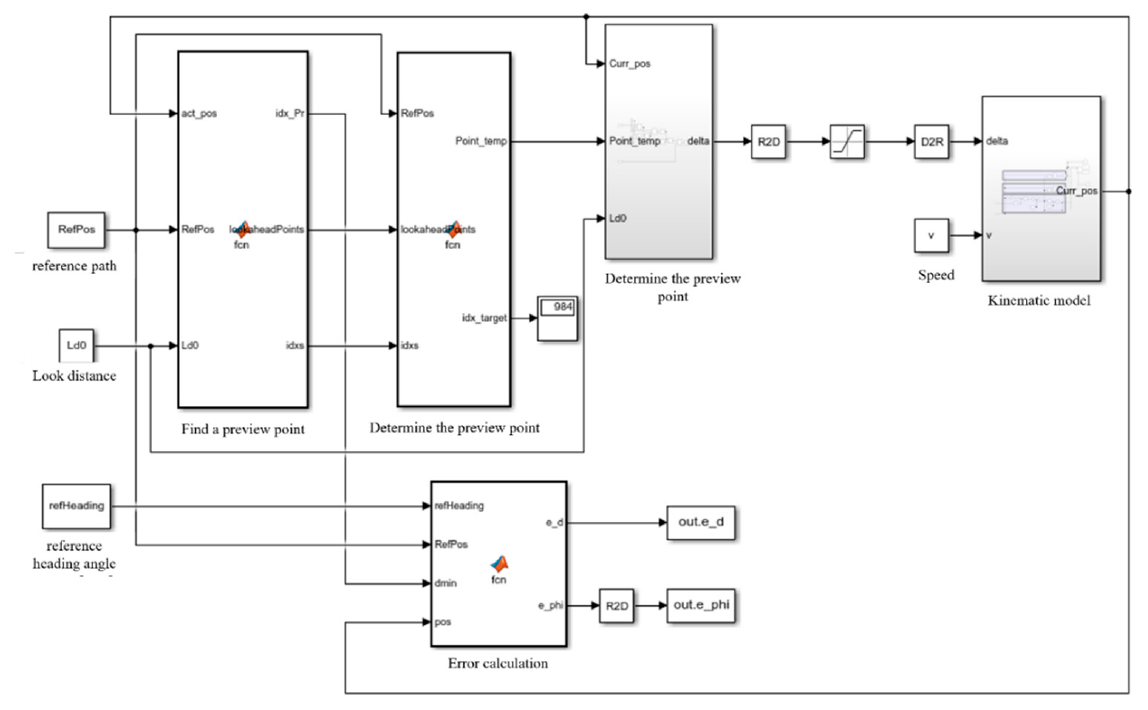
Figure 5. Simulation model of 4WS pure tracking algorithm.